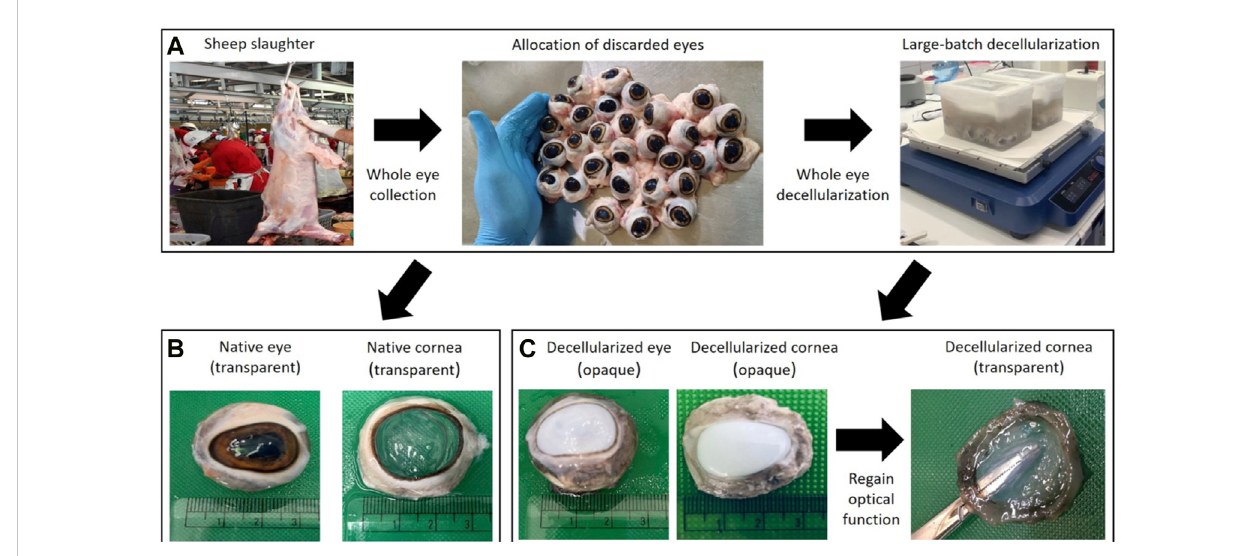
FIGURE 1 A schematic of the high-throughput system used to generate corneal tissues from slaughterhouse waste. Photographs in panel (A) illustrate the whole eye allocation and large-batch decellularization processes post-slaughter. Photographs in panel (B) highlight theretentionof ocular transparency in native corneas using an index-matching agent (glycerol), while those in panel (C) display the reversal of ocular opacity in decellularized tissues using this clearing agent. Opacity is an established consequence of certain forms of corneal extraction and storage, and